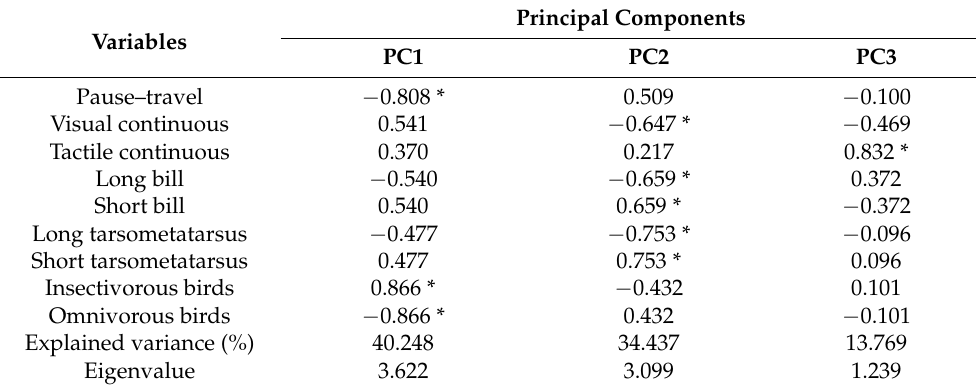
Table 4. Principle component analysis results based on nine